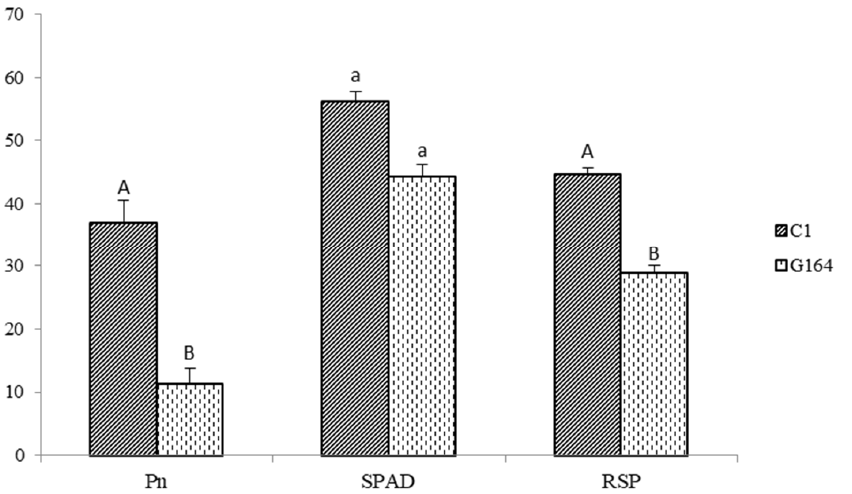
Figure 3. Photosynthetic rate and chlorophyll value of high- and low-light efficiency germplasm resources. Note: Data are means of three replicates. The uppercase and lowercase letters represent 1% and 5% level of significance of difference,